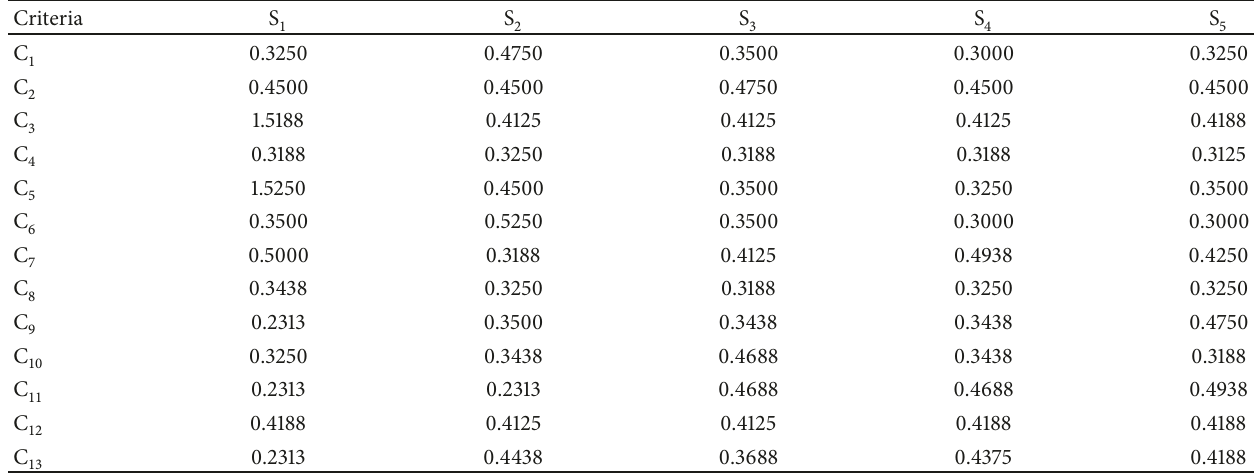
Table 12: System area for the maintenance systems.